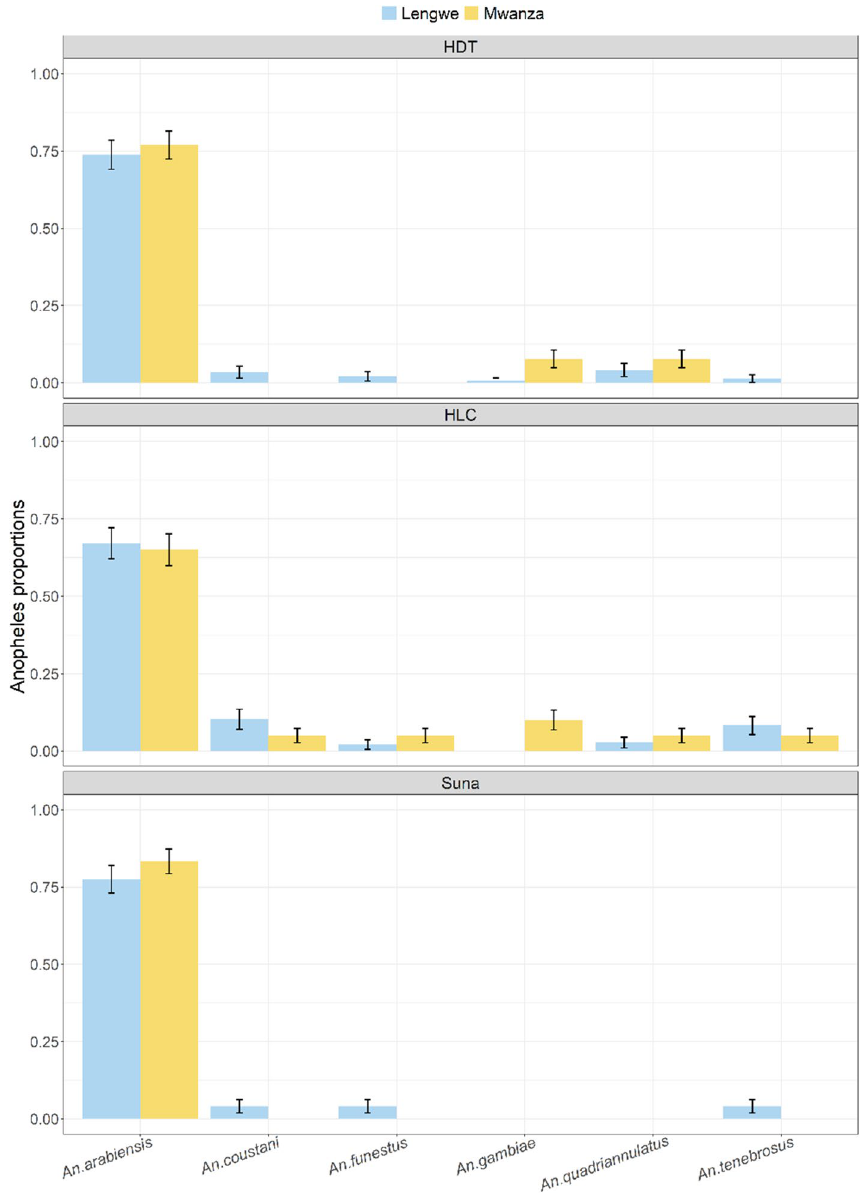
Figure 2. Relative Anopheles species composition (proportions ± s.e.m) for the HDT, HLC and Suna trap in the Nchalo sugar estate, Malawi. Data are presented for each study